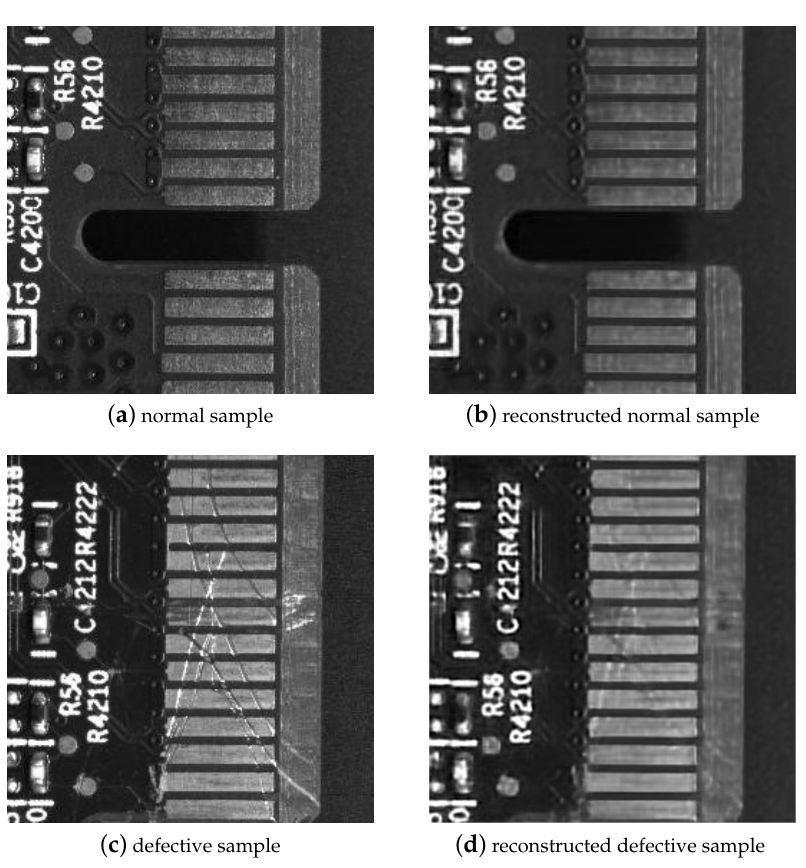
Figure 9. Examples of the input test images and their reconstructions by the AE for gold finger connector images: ( a ) normal test sample; ( b ) reconstructed normal test sample by the AE; ( c ) defective test sample; ( d ) reconstructed defective test sample by the